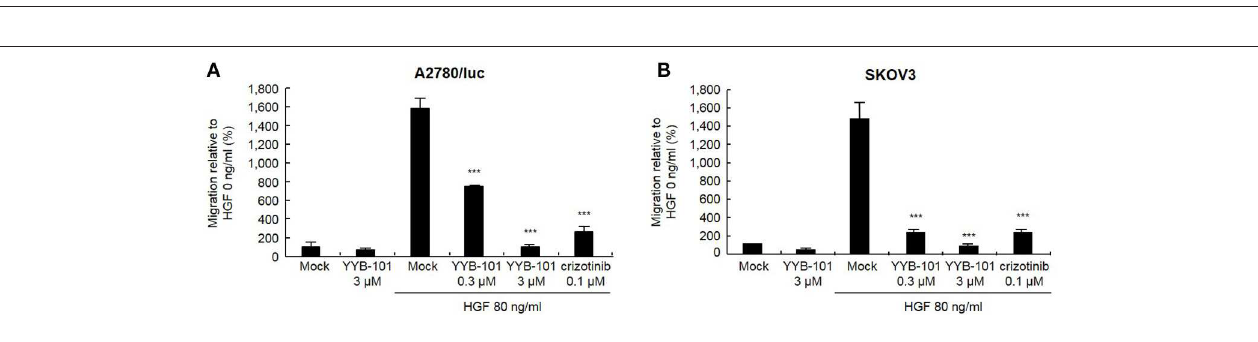
YYB-101, or both compared with the control mice, with the